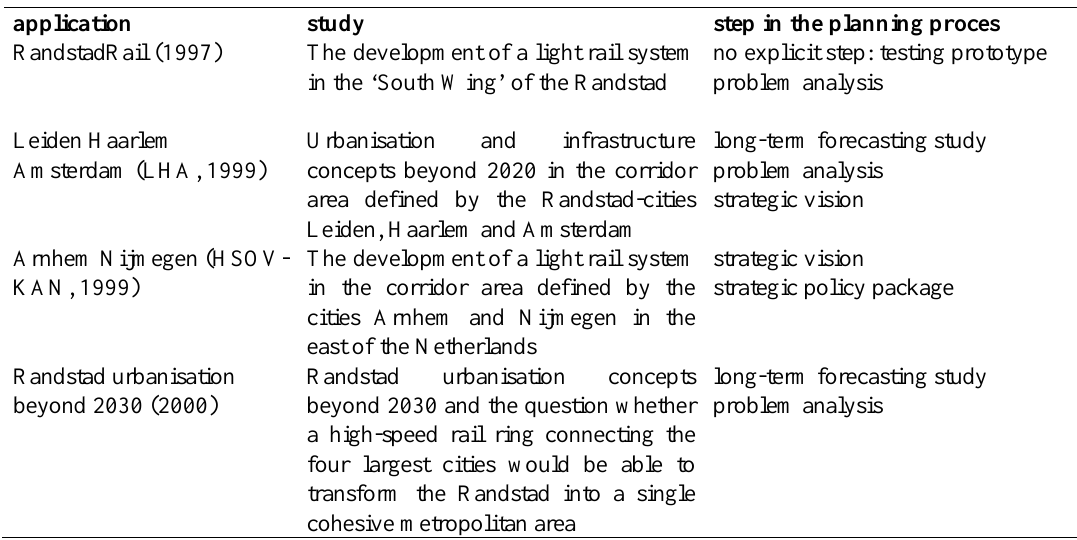
Table 2: 4 TIGRIS applications of the Ministry of Transport, national scale.